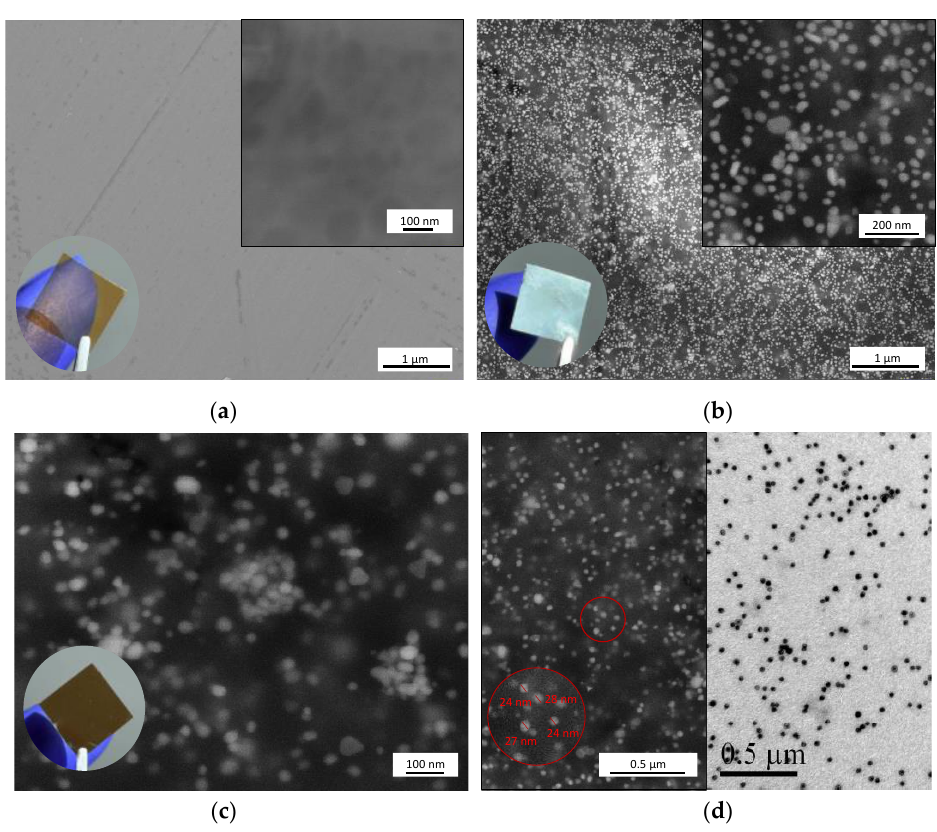
Figure 3. Scanning electron micrographs of polymer films: ( a ) control sample F3 without AgNPs, ( b ) F2Ag, ( c ) F3Ag and ( d ) comparison of SEM ( left ) and transmission electron microscopy (TEM, right ) micrographs of F3Ag.